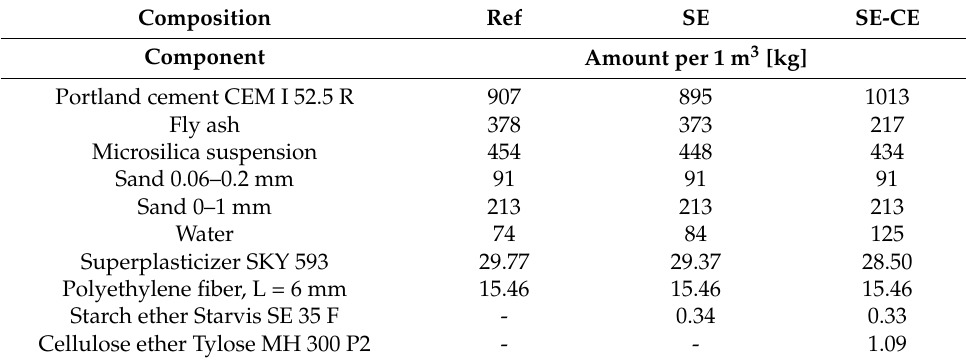
Table 1. Compositions of printable